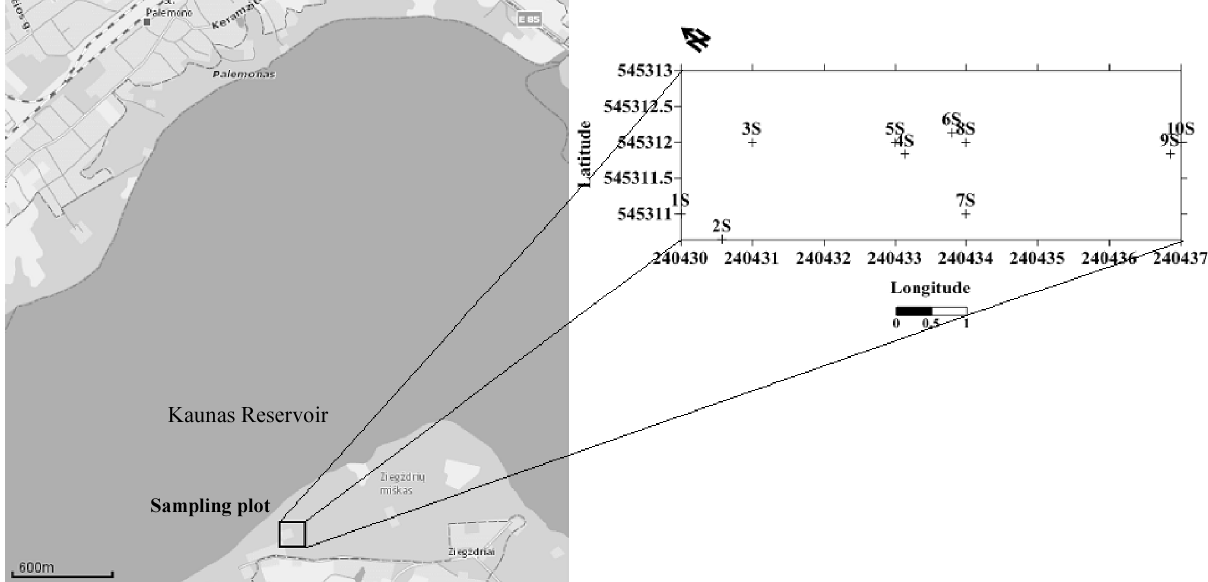
Fig. 3. Location of the control study plot (54 0 53´12´´N, 24 0 04´35´´E). 1S, 2S, 3S etc. – trees sampled on the control